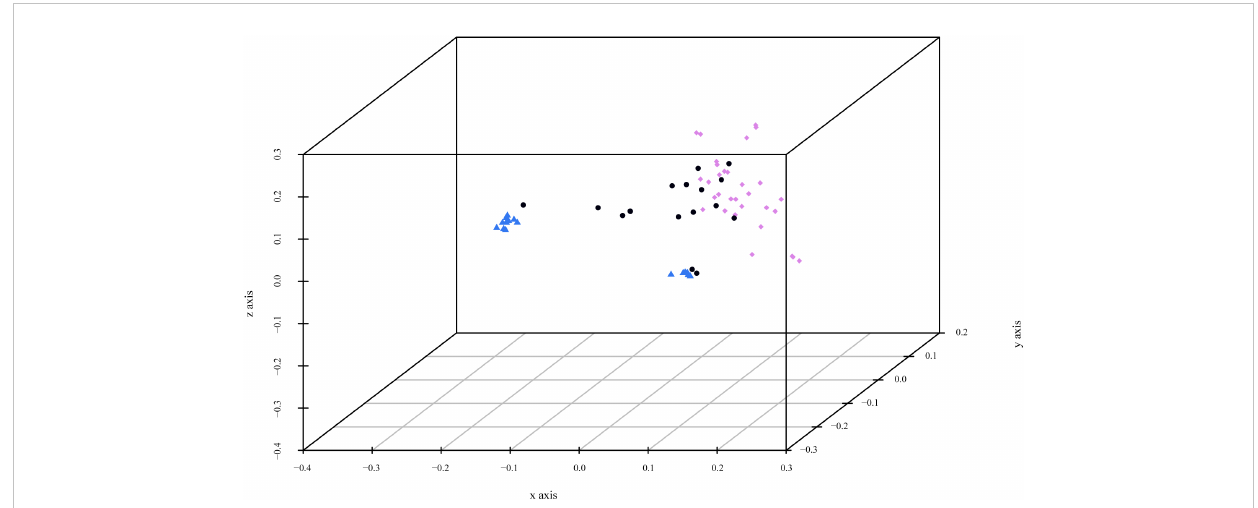
FIGURE 5 3D graph of Principal Coordinate Analysis (PCoA) based on polymorphism at 11 SSR loci of the 71 P . domestica genotypes. The colors of the accessions indicated the clusters obtained by Bayesian analysis for K=2: Bluish plum accessions and common prunes collected in Slovenia (blue), plums genetically very diverse (violet). Accessions located between the two clusters (in black) correspond to the admixed